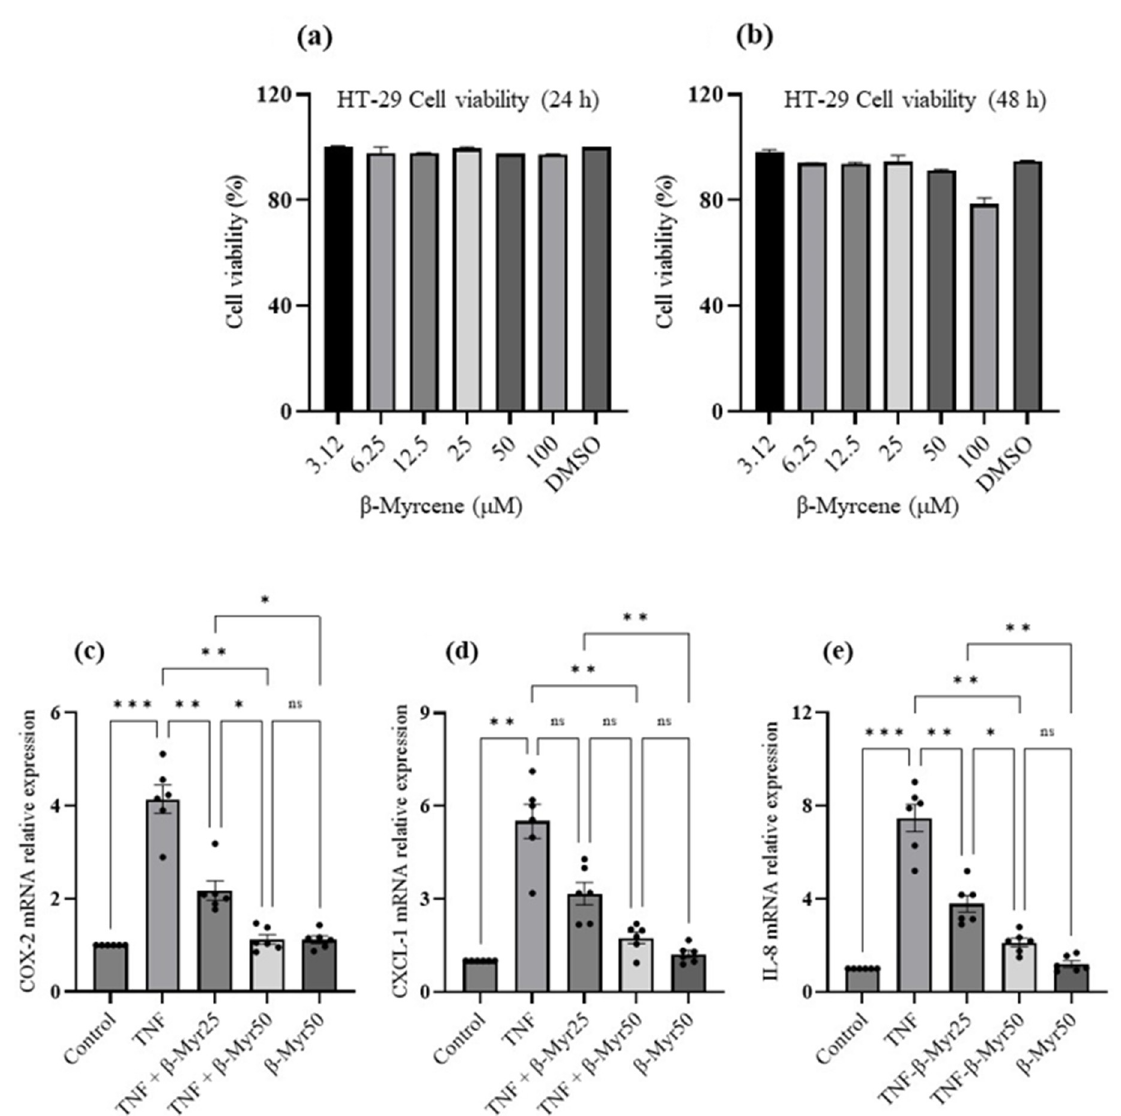
Figure 6. Effect of β -myrcene cell viability and on TNF- α challenged HT-29 colonic adenocarcinoma proinflammatory chemokine mRNA expression. ( a , b ) A dose-dependent concentration ( µ M) of β -myrcene was exposed (24 h and 48 h) to HT-29 cells to analyze the cell toxicity effect. β -myrcene did not affect the cell viability up to 100 µ M concentration at either time (24 h and 48 h) point. HT-29 cells were challenged with TNF- α for 24 h and subsequently exposed to β -myrcene (25 and 50 µ M) and proinflammatory mediator ( c ) (COX-2) and chemokine ( d , e ) (CXCL1 and IL-8) mRNA was analyzed. β -myrcene significantly prevented the increase in COX-2, CXCL-1 and IL-8 mRNA levels in TNF- α -treated cells. Data were obtained from n = 6 samples. Data expressed as mean ± SEM. p values were obtained by one-way ANOVA followed by Tukey’s multiple comparison test. * p ≤